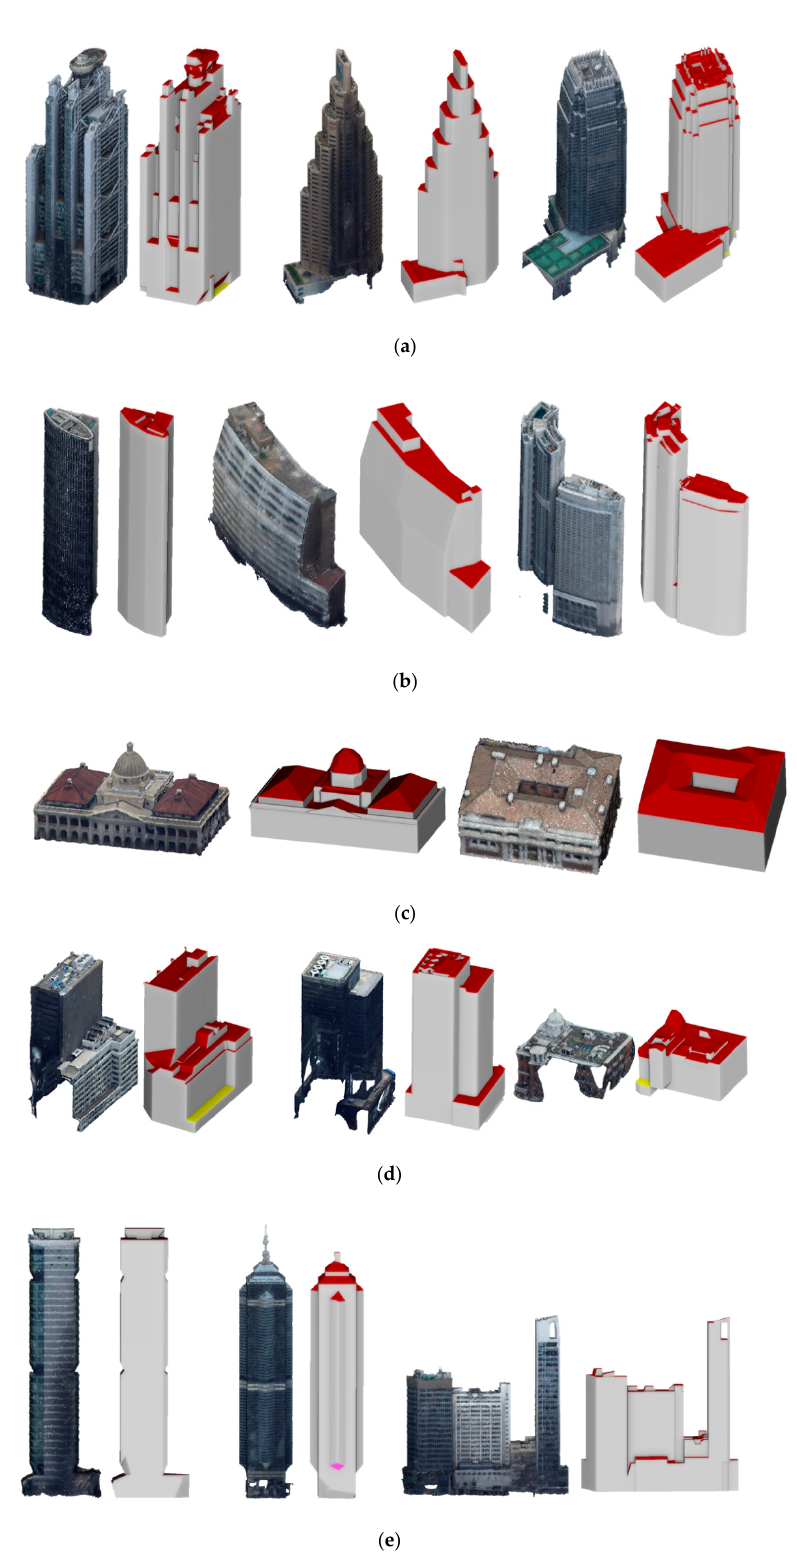
Figure 17. Reconstruction results of five challenging types of buildings shown in CityGML format. Red, grey, yellow, and pink indicate roof, wall, outer-floor, and outer-ceiling surfaces, respectively. ( a ) Buildings with complex structures; ( b ) Buildings with curved surfaces; ( c ) Buildings with typical European architectural styles; ( d ) Buildings with missing data; ( e ) Buildings with true 3D structures. For quantitative evaluation of the accuracy of the generated models, the root-mean- square error (RSME), as given by Equation (12), was used to measure the differences be- tween the input point cloud and the generated model.